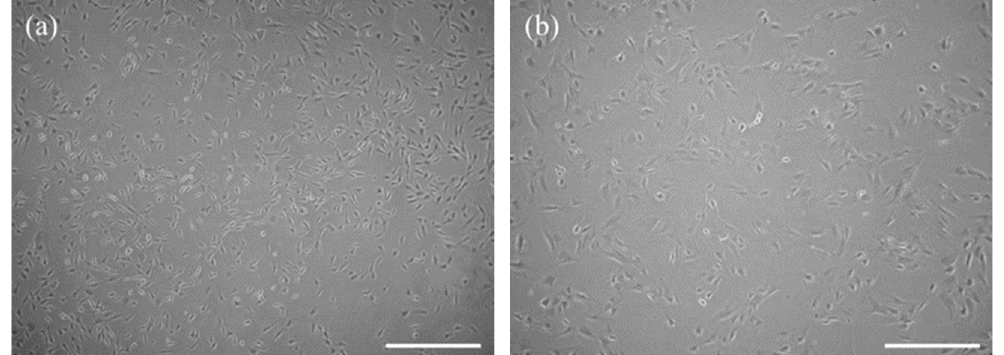
Figure 1. The morphology of canine Müller-like cells (CaMLCs). The cells were captured using an inverted microscope with phase contrast. Magnification was 50× ( a , scale bar 500 μ m) and 100× ( b , scale bar 250 μ m) and they exhibited features typical for glia-like cells.